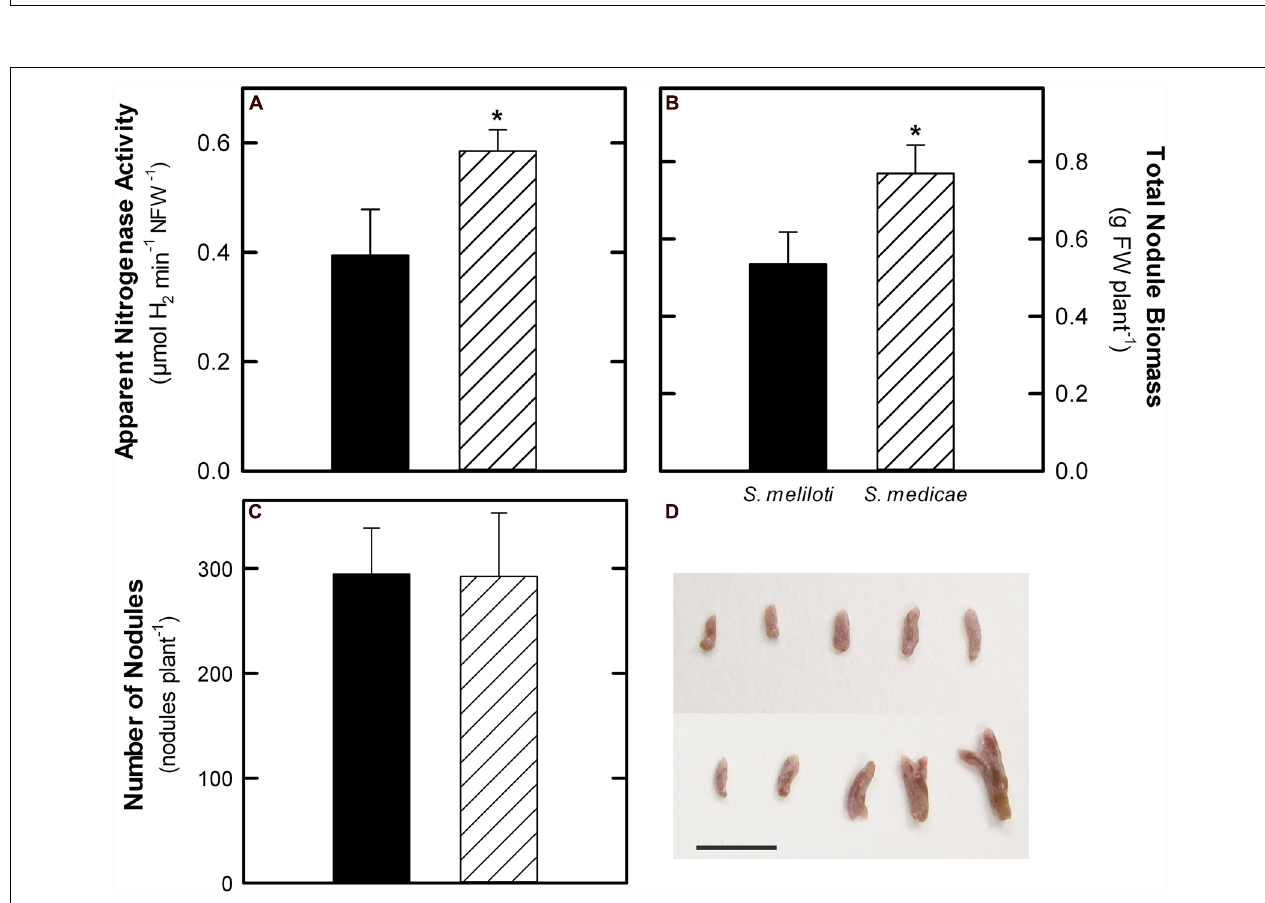
FIGURE 3 | N 2 -fixation rates measured as apparent nitrogenase activity (ANA, A), total nodule biomass (B), nodule number (C) in M. truncatula plants inoculated with either S. meliloti 2011 or S. medicae WSM419. D , representative image of nodules sampled from